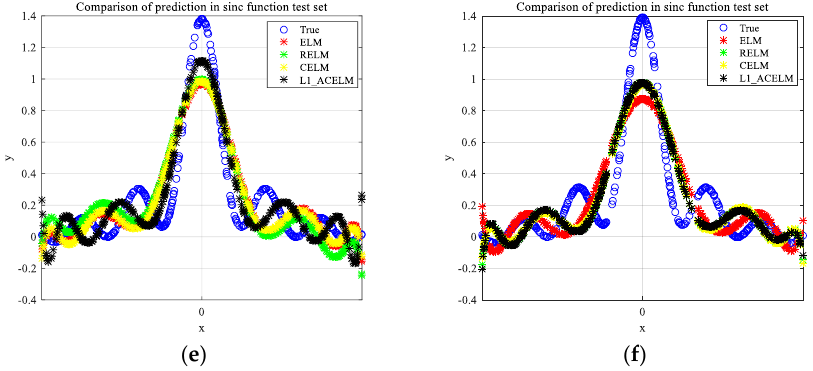
Figure 4. Fitting results of the sinc function with different noises.